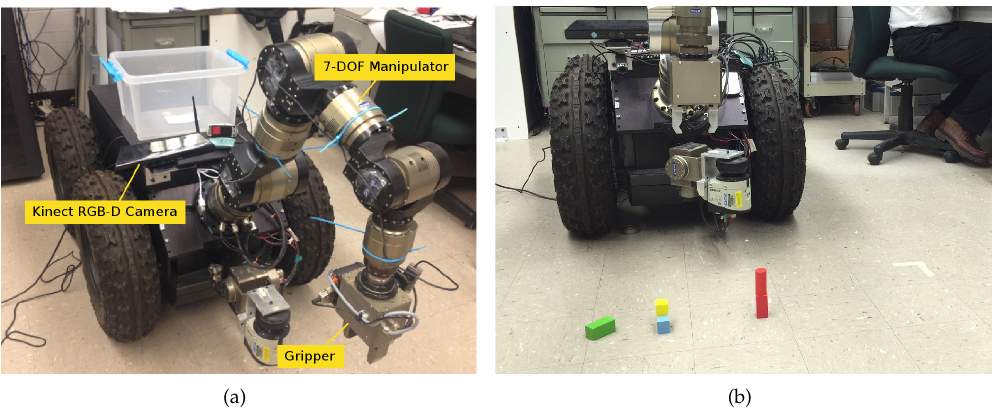
Figure 10. Our mobile manipulator ( a ) and an environmental setup ( b